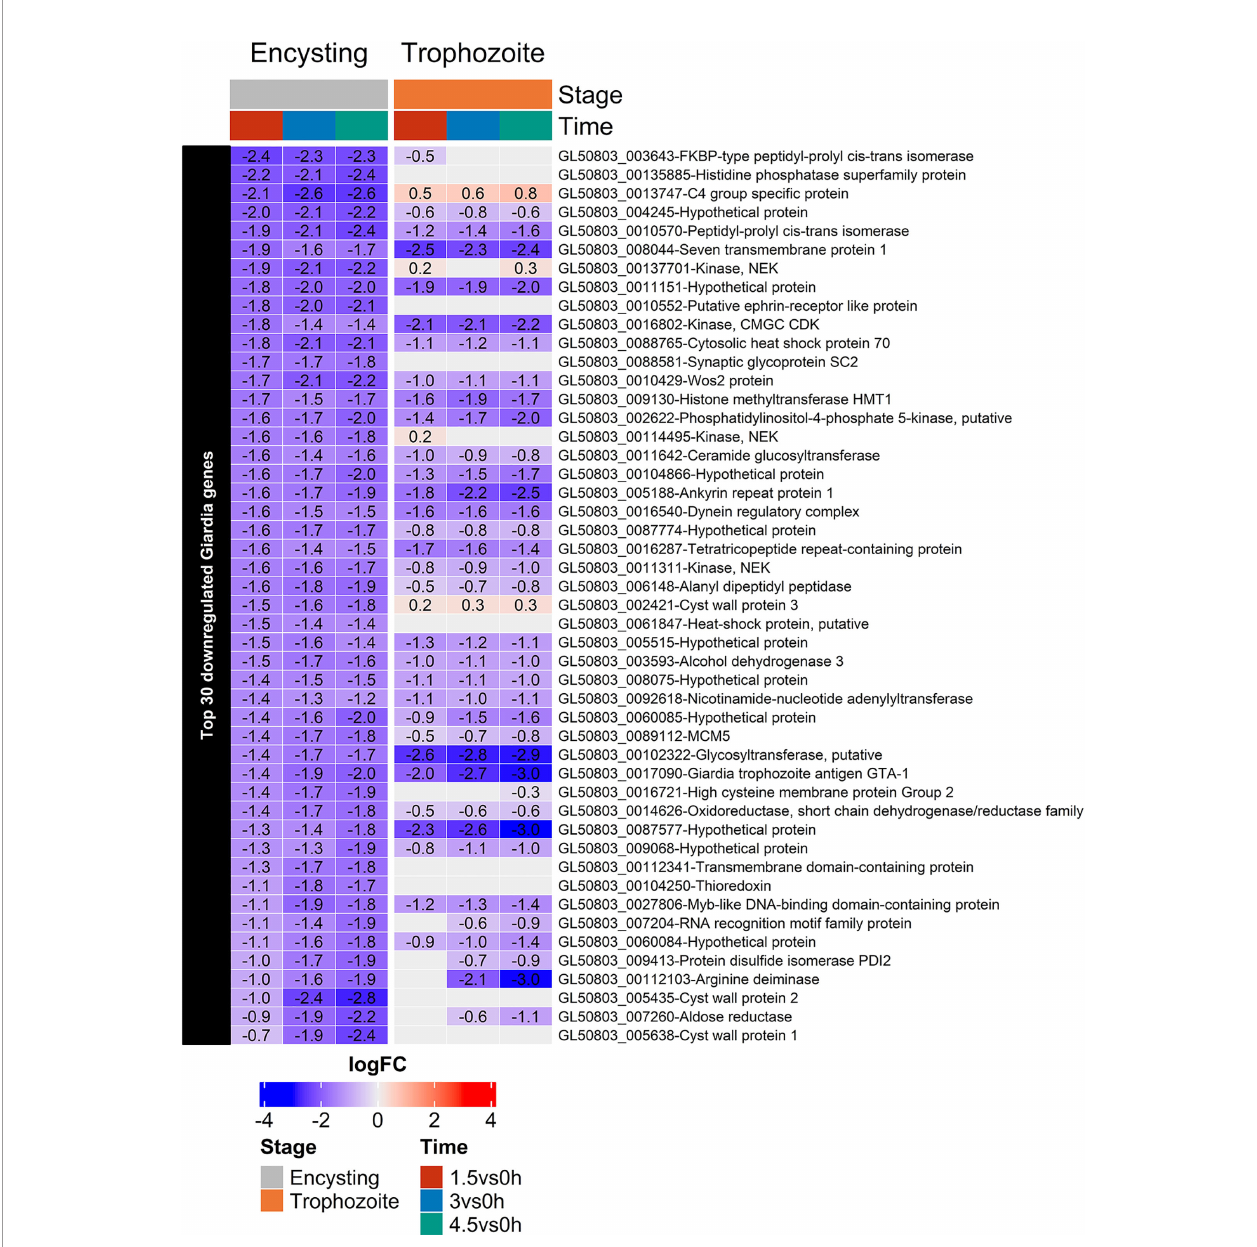
FIGURE 7 | Heatmap of the top 30 down-regulated genes in encysting Giardia cells during Caco-2 infections at timepoints 1.5, 3, and 4.5h during Caco-2 infection compared to trophozoite differentially regulated genes at the same infection timepoints. Only signi fi cant values are shown, insigni fi cant values are set